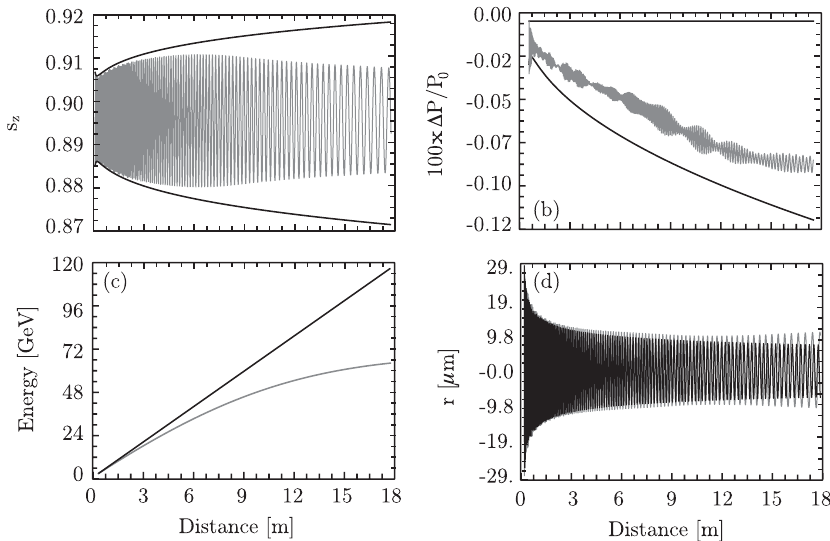
FIG. 6. QUICKPIC simulation results for an externally guided LWFA, using a 800 J laser pulse to accelerate a zero-emittance electron beam to 70 GeV. The predictions of the model are shown in black, and the results of the simulation shown in gray. Part (a) shows the for a randomly chosen beam electron. Part (b) shows the evolution of the total polarization. The black curves are the evolution of s z . Part (c) shows the evolution of the electron beam energy. Part (d) analytical results for the maximum and minimum values of (cid:3) P=P 0 shows the radial trajectory of the same electron of